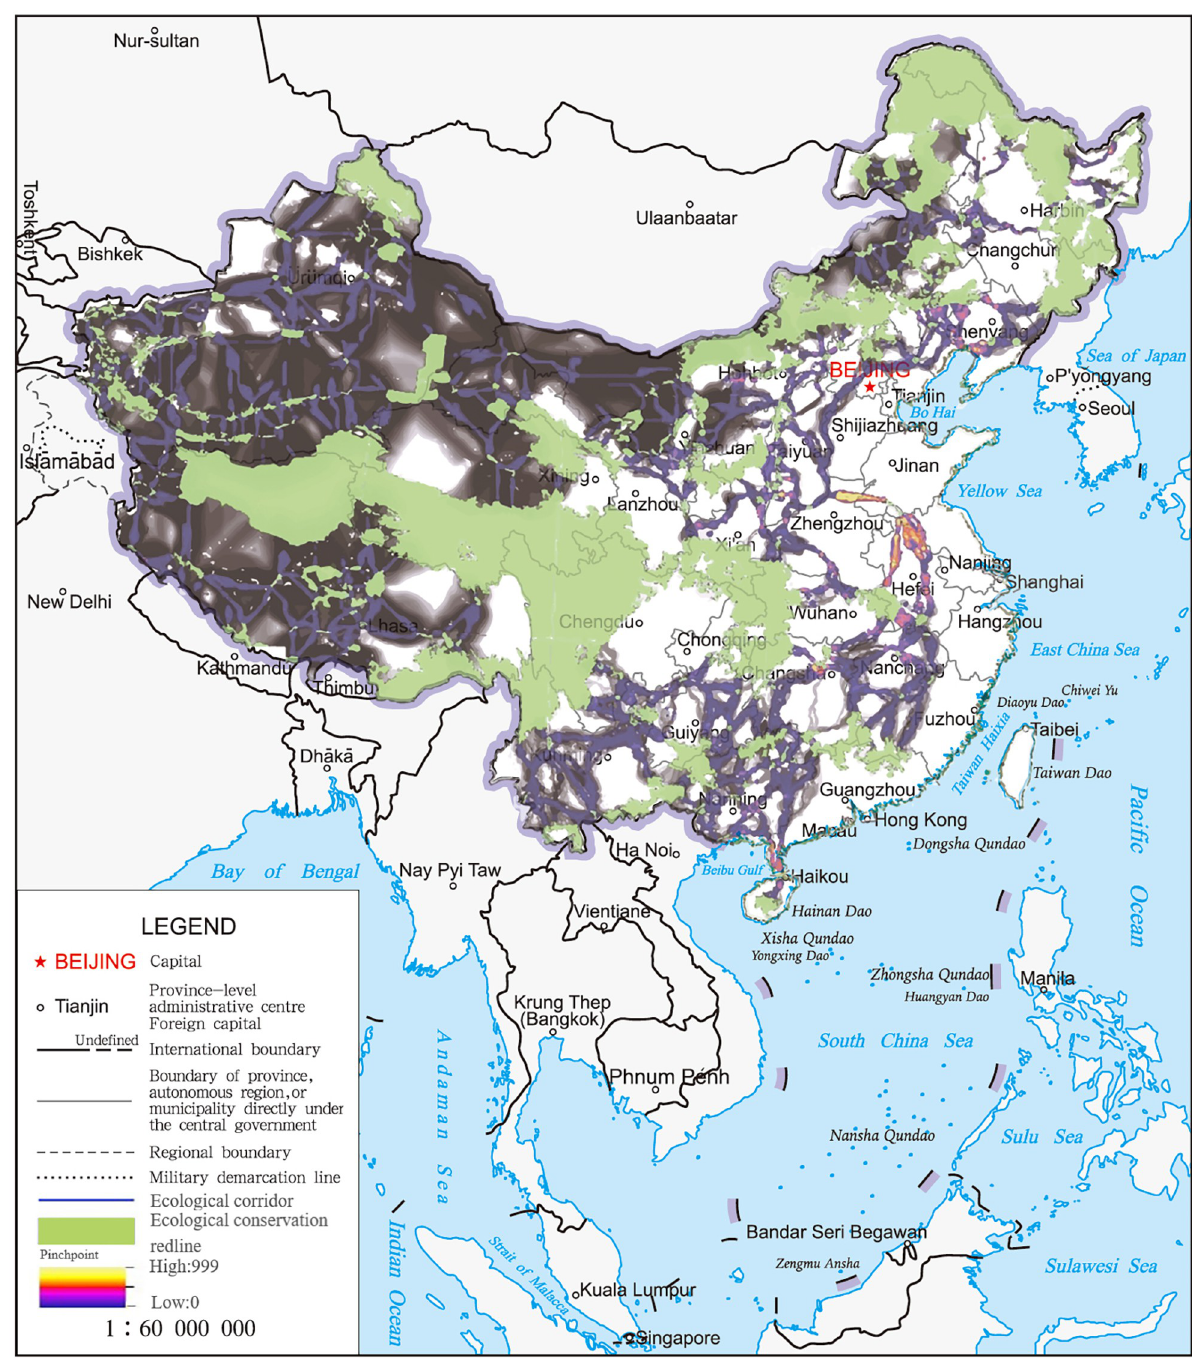
Fig 5. Diagrammatic map of pinchpoint distribution of ecological corridors at the national scale. region; (6) the key area of Jiuquan City; (7) the intersection area of the southeastern Bayingol and the western Qinghai Province; (8) the southwest of the Hotan region; and (9) the longitudi- nal ridge-valley region in the southwest. During the implementation of the ECR policy, we should focus on the protection and strengthening of ecological construction in key areas.